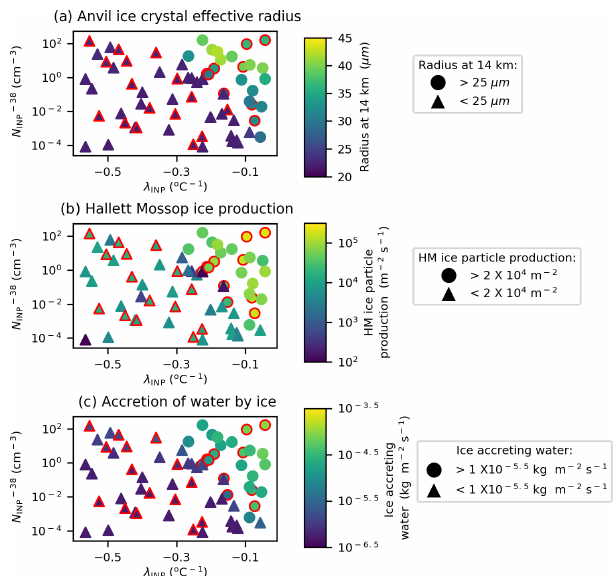
Figure 10. Regime change in anvil ice crystal effective radius and driving processes. Variation in anvil ice crystal effective ra- dius (a) , ice particle production by the Hallett–Mossop process (b) , and the accretion of water by ice crystals (c) due to variation in λ INP and N INP − 38 . Marker colours indicate the value of anvil ice crystal effective radius (a) , ice particle production by the Hallett– Mossop process (b) , and the accretion of water by ice crystals (c) . Circular markers indicate an ice crystal effective radius above 25µm (a) , an ice particle production by Hallett–Mossop exceed- ing 2 × 10 4 m − 2 s − 1 (b) , and a rate of water accretion by ice over 1 × 10 − 5 . 5 kgm − 2 s − 1 (c) . Simulations with a HM-eff above 600splintersmg − 1 are indicated with a red outline. Panel (a) is the average of the cloud property between 150 and 240min (anvil stage) of the simulation, while panels (b) and (c) are the average of the rel- evant cloud property between 60 and 180min (convective stage) of the simulation.